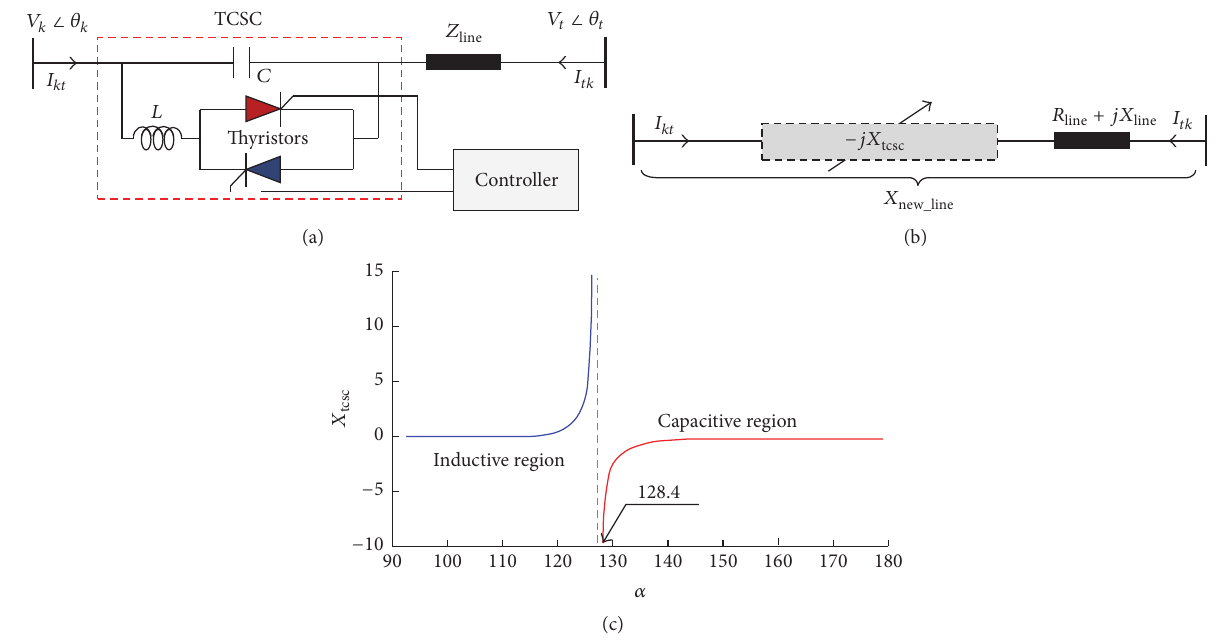
Figure 3: The TCSC controller: (a) structure; (b) equivalent; (c) reactance versus firing angle characteristic